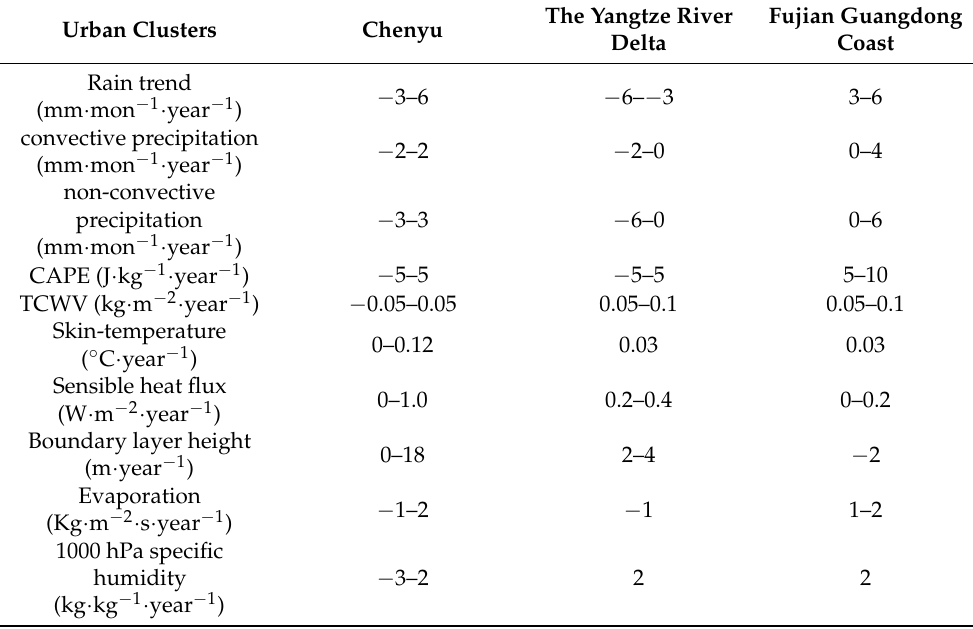
Table 2. The trend of rain, CAPE, TCWV, skin-temperature, sensible heat flux, boundary layer height, evaporation, 1000 hPa specific humidity in warm season during 1998 to 2014. Urban Clusters Chenyu